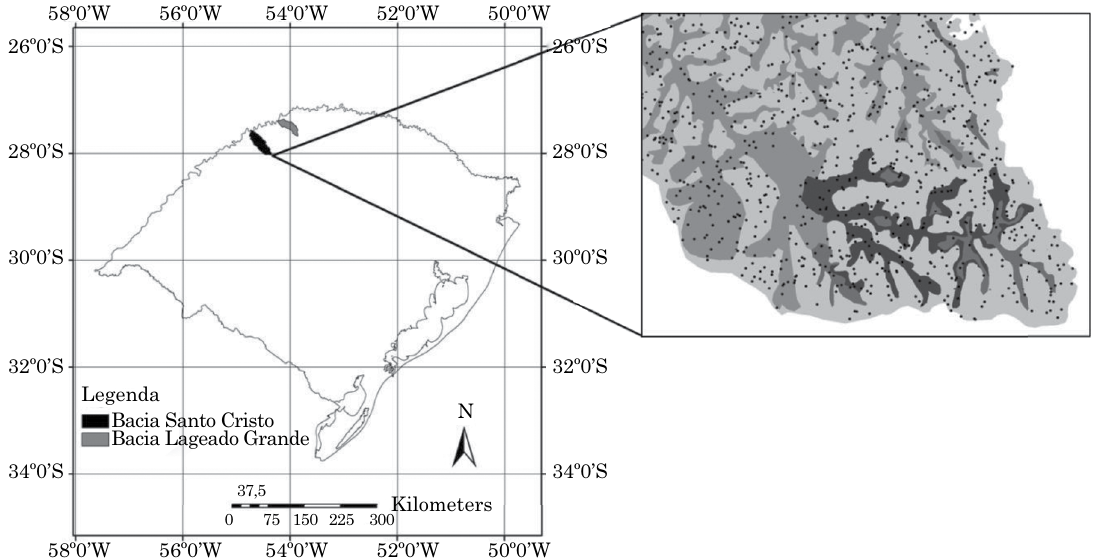
Figura 1. Localização das bacias hidrográficas dos Rios Santo Cristo e Lageado Grande no Estado do Rio grande do Sul e esquema de distribuição dos pontos de amostragem, com densidade de 0,1 ponto por